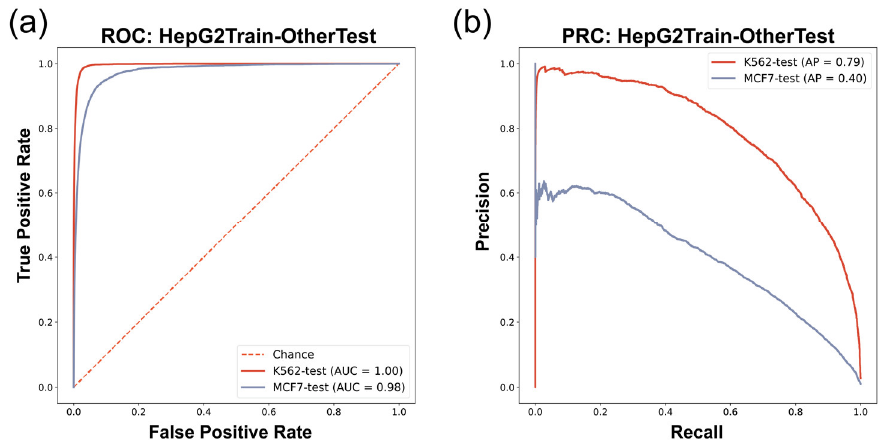
Figure 4. Cross-cell-line evaluation ROC/PRC results. ( a ) ROC of HepG2-dataset-trained model predicting in vivo G4s of K562/MCF7 cell lines. ( b ) PRC of HepG2-dataset-trained model predicting in vivo G4s of K562/MCF7 cell lines.